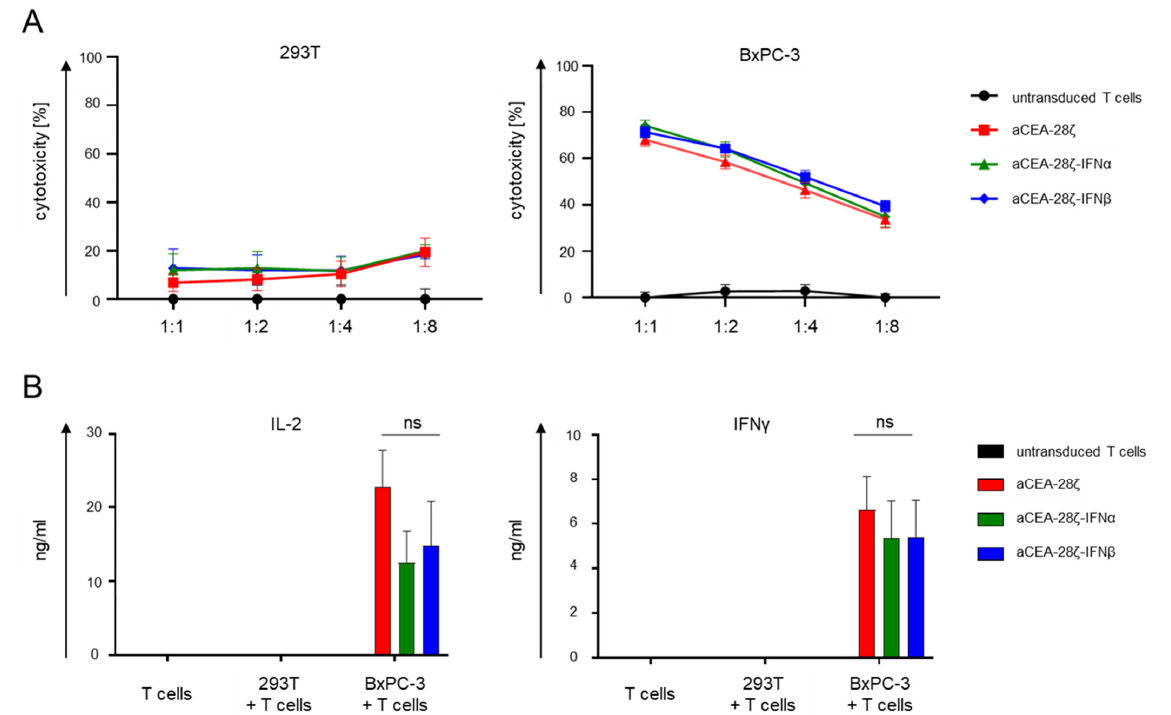
Figure 2. Upon first activation, IFN-CAR and conventional CAR T-cells show similar cytotoxicity and cytokine secretion. ( A ) Cytotoxicity of CAR T-cells was recorded upon a 24 h co-culture with 293T cells or BxPC-3 cells at the indicated effector-to-target ratios. Data represent means ± SEM of three donors, p values were calculated by Student´s t test, ns indicates not significant. ( B ) ELISA-based quantification of IL-2 and IFN γ accumulated in the culture supernatant after 48-h co-culture of CAR T-cells without or with 293T cells or BxPC-3 cells. Data represent means ± SEM of three donors, p values were calculated by Student´s t test, ns indicates not significant.